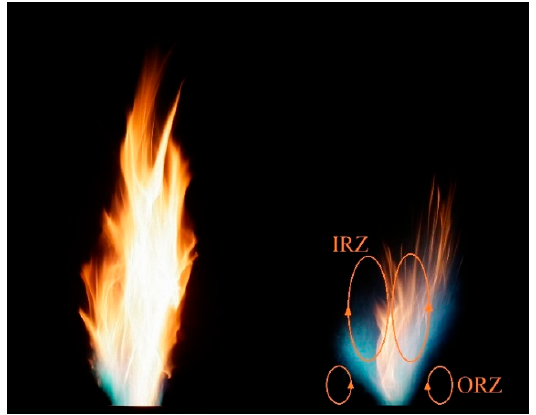
Figure 3. Straight flame state near the end of the transitory regime ( left , p g = 0.3 bar, λ = 1.1, and S’ = 0.82) and V-shaped flame ( right , p g = 0.3 bar, λ = 1.23, and S’ = 0.91) of BL-D [46].